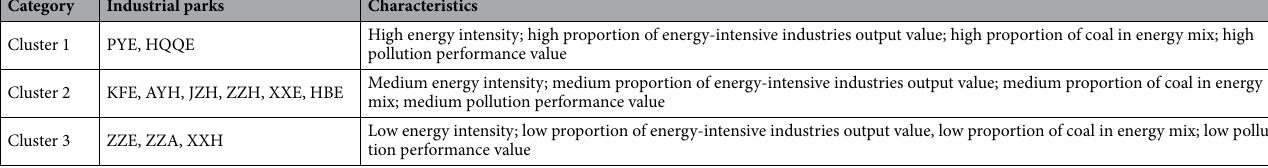
Table 5. Clustering results of industrial park.